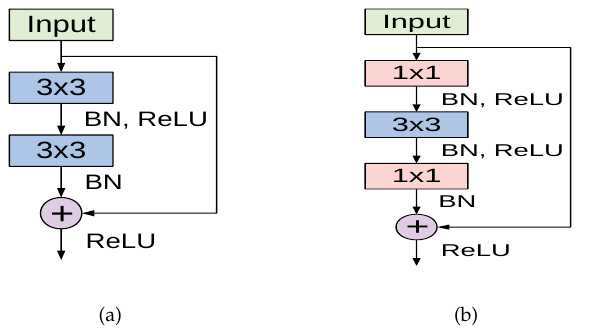
Figure 3. The basic residual module used in ResNet18 ( a ), and the bottleneck residual module utilized in ResNet50 and ResNet101 ( b ), both as introduced in